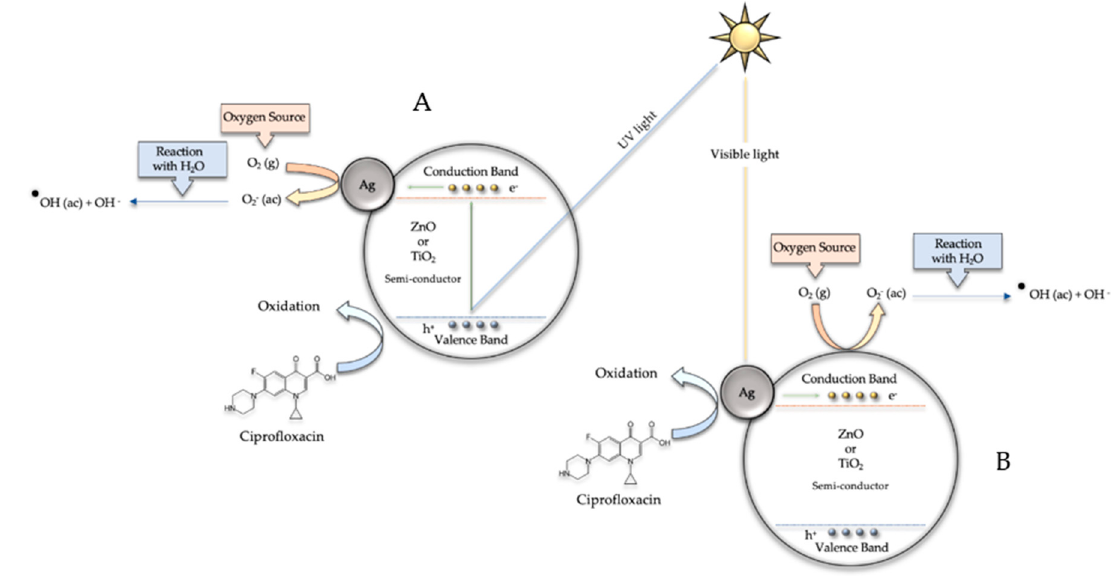
Figure 11. Mechanism for the degradation of ciprofloxacin using the silver-based catalysts under ultraviolet ( A ) and visible light ( B ).